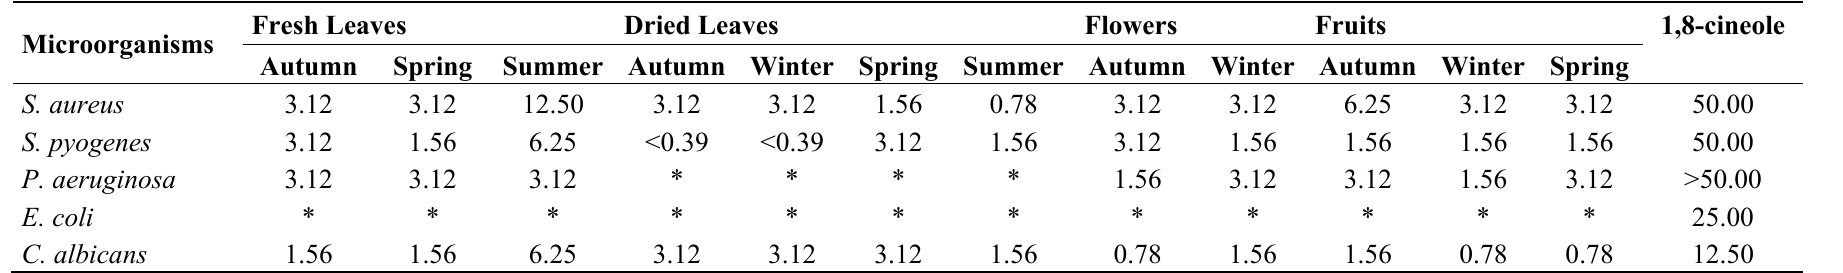
Table 5. MIC (mg/mL) of essential oils from leaves, flowers and fruits of E. cinerea and of